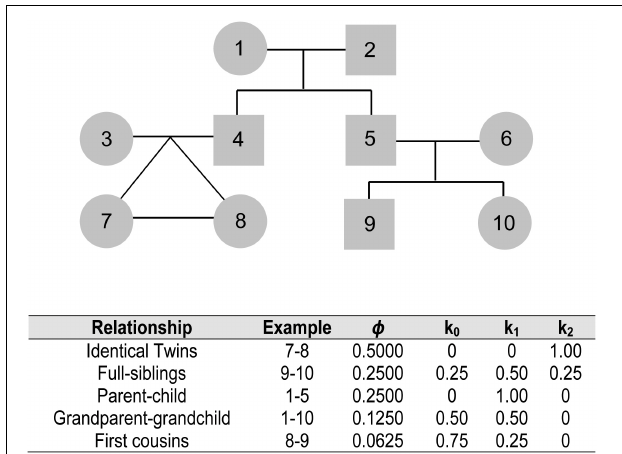
FIGURE 1 | Pedigree showing the degrees of relationship between selected pairs of individuals and corresponding inbreeding coefficients ( φ ) and k 0 , k 1 , k 2 values describing the probabilities of a given pair of individuals of sharing, respectively zero, one or two alleles that are